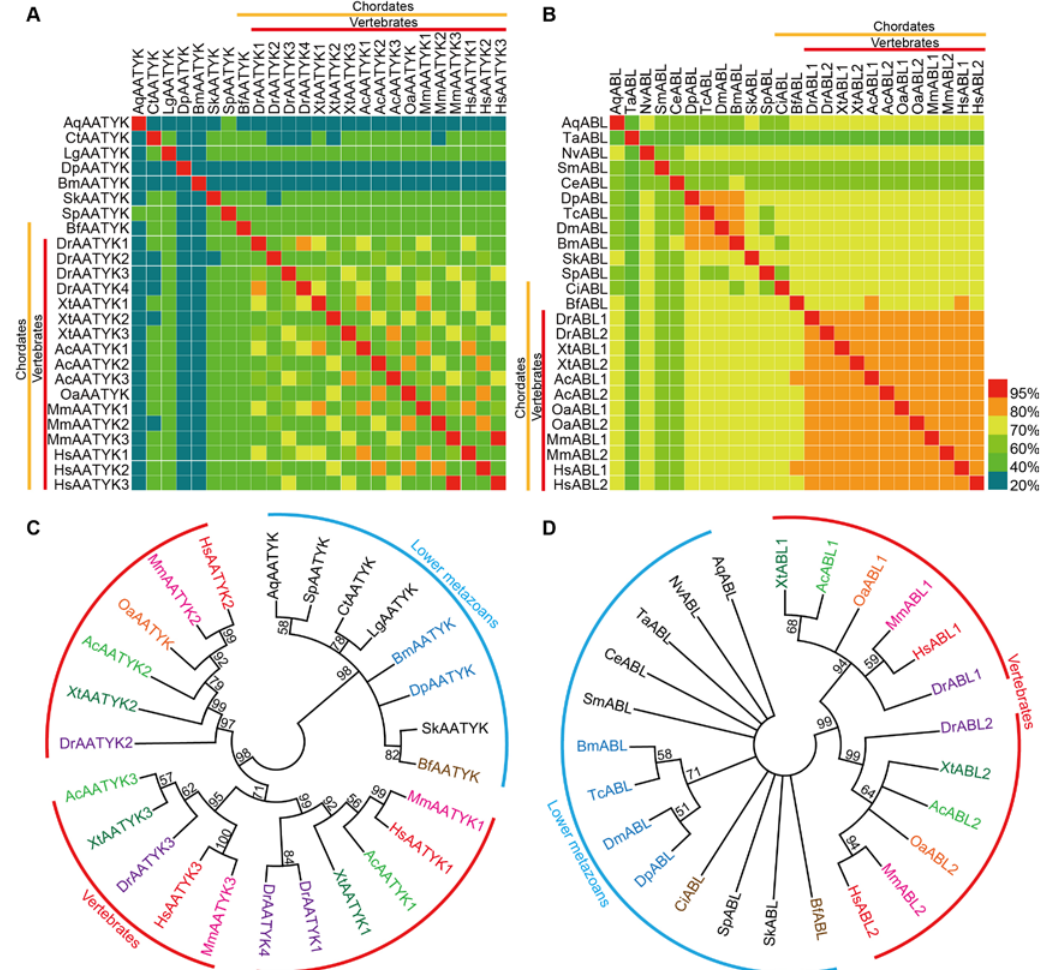
Figure 2. Sequence identity matrices and phylogenetic analysis of AATYK and ABL subfamilies members in metazoans. ( A , B ) Sequence identity matrices. The yellow and red lines on the X and Y axes indicate chordates and vertebrates, respectively. ( C , D ) TK domain sequence-based phylogenetic trees. The ML (Maximum-Likelihood) trees are based on multiple sequence alignments of TK domains from AATYK and ABL subfamilies. Bootstrap values below 50 are not shown. Chordates and arthropods are indicated by different colors. The red arcs indicate the different protein classifications of the higher chordates (i.e., vertebrates). The blue arcs indicate the proteins of lower metazoans. Corresponding species names for the abbreviations are listed in Table S2.